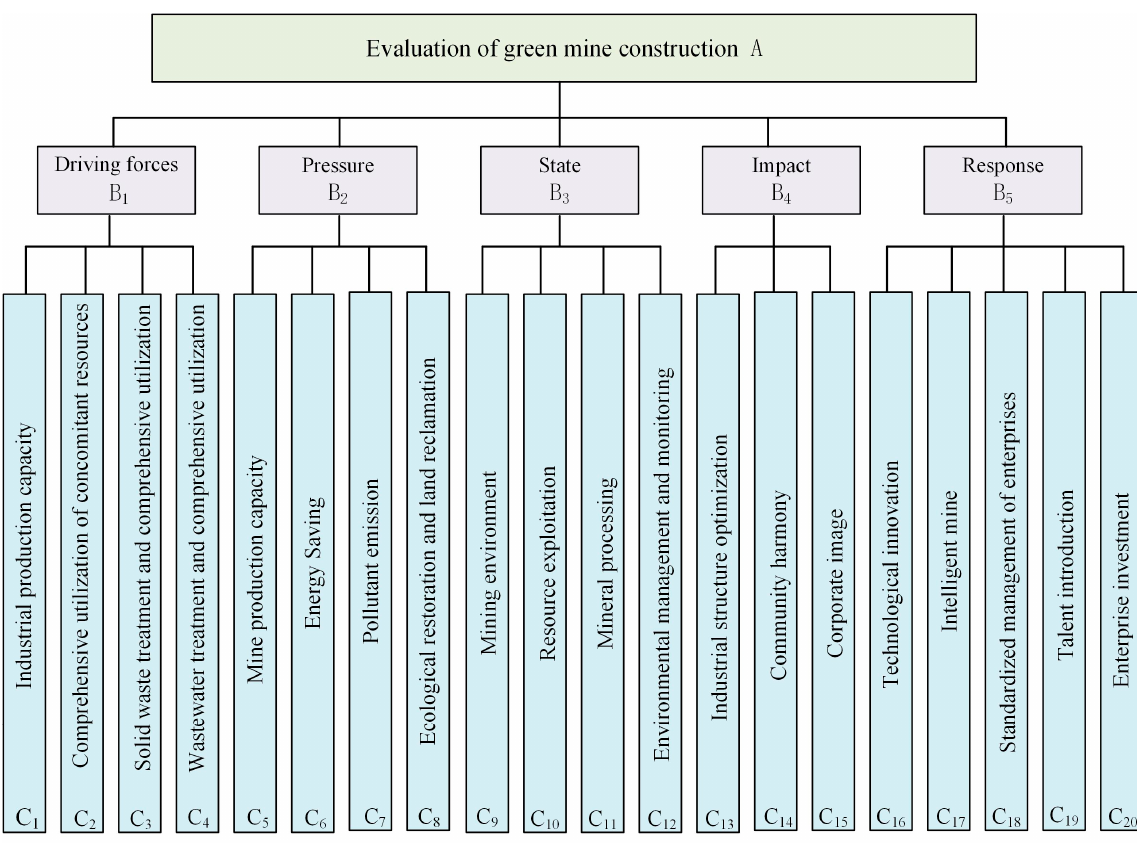
Figure 3. Green mine evaluation index system.